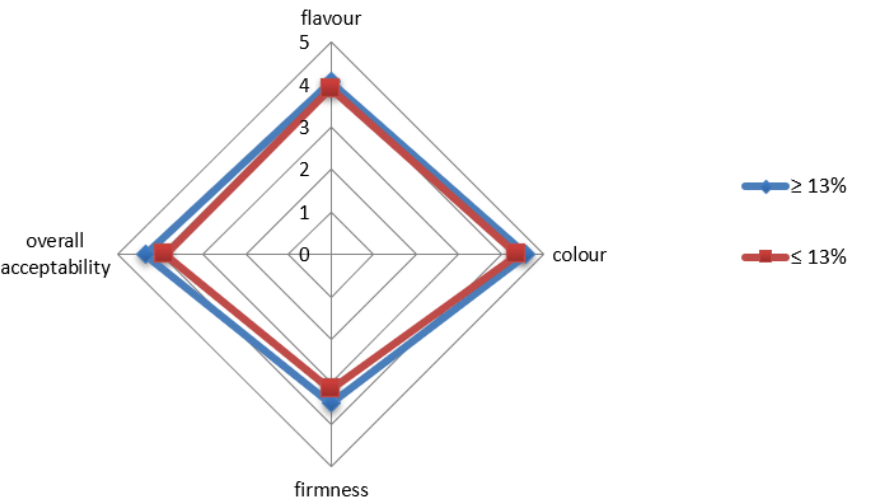
Figure 5. Sensory properties of pasta samples. Each attribute was assessed on a 5-point scale from 1, low intensity, to 5, high intensity.